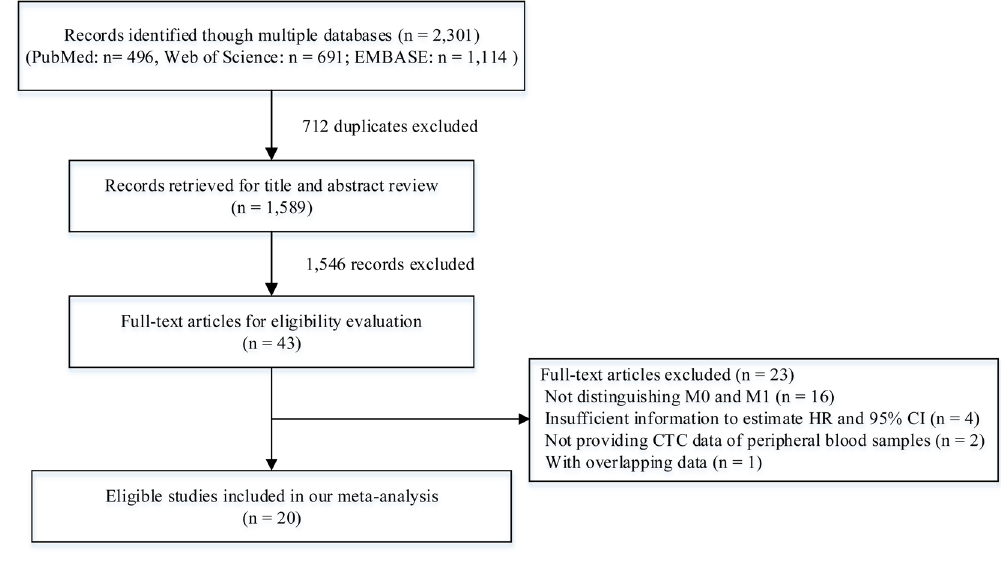
Figure 1. A flowchart of literature